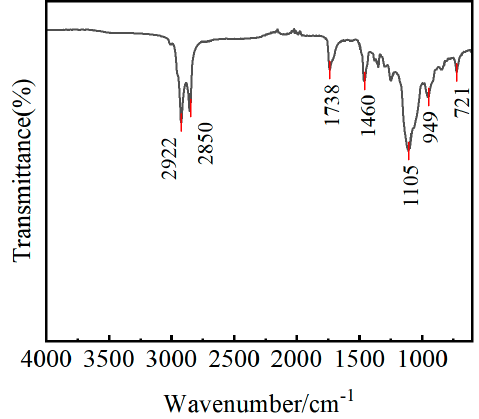
Figure 17. FTIR spectrum of release agent INT − 1890M.